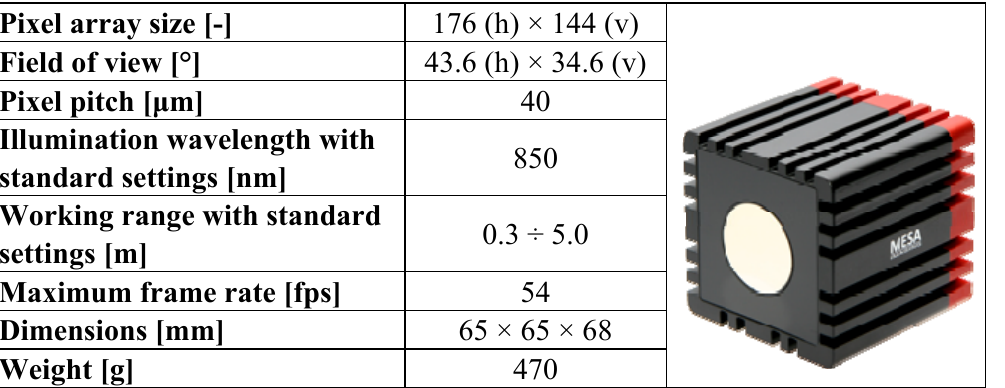
Table 1. SR-4000